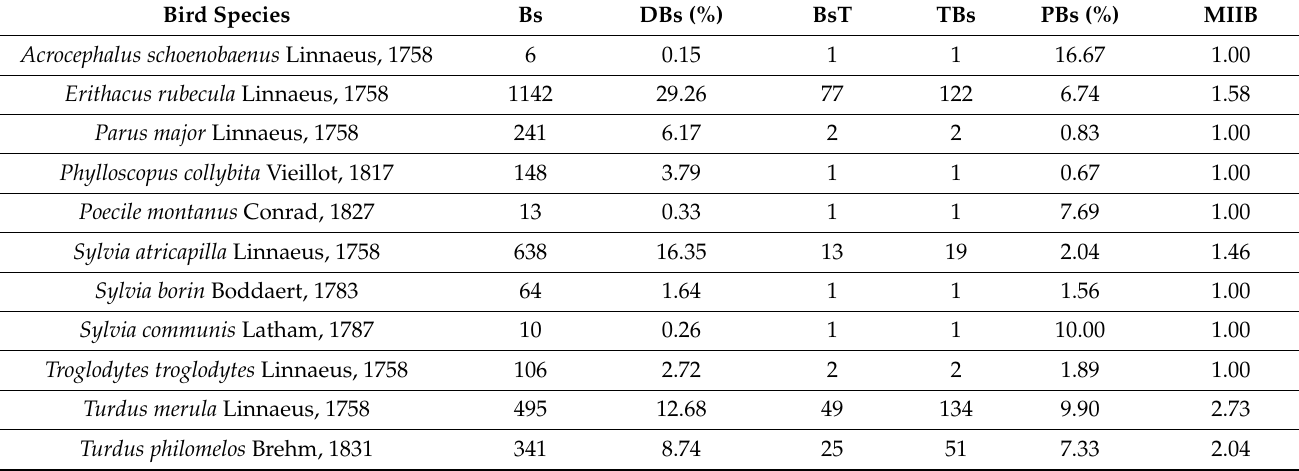
Table 1. Tick infestation among the analyzed bird